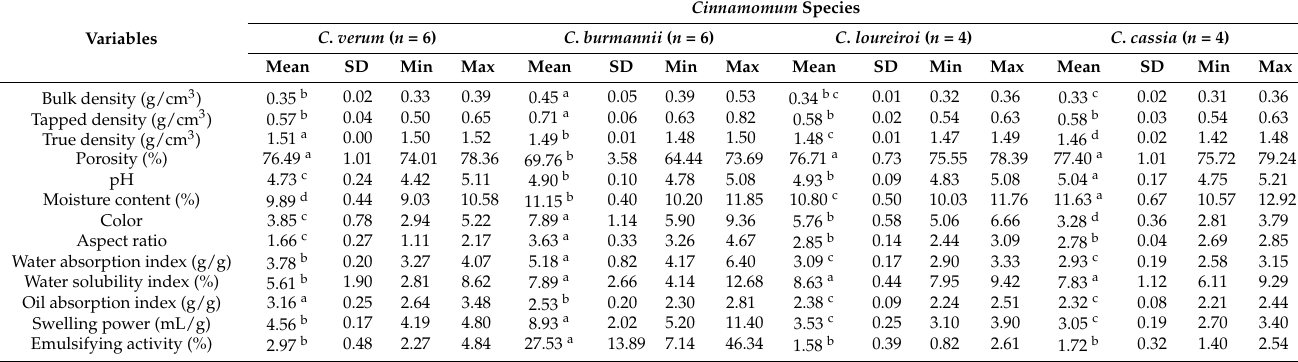
Table 1. Descriptive statistics for physico-functional properties of cinnamon samples from four Cinnamomum species.